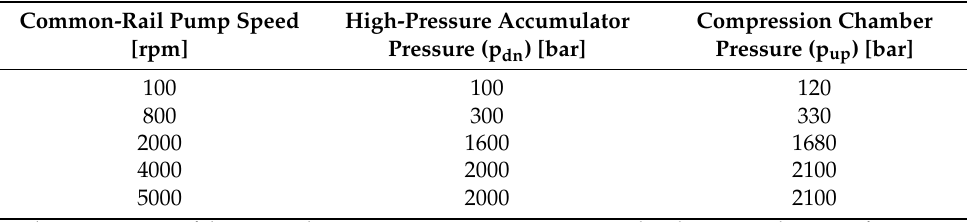
Table 1. Typical working pressures depending on the speed of the pump. Common-Rail Pump